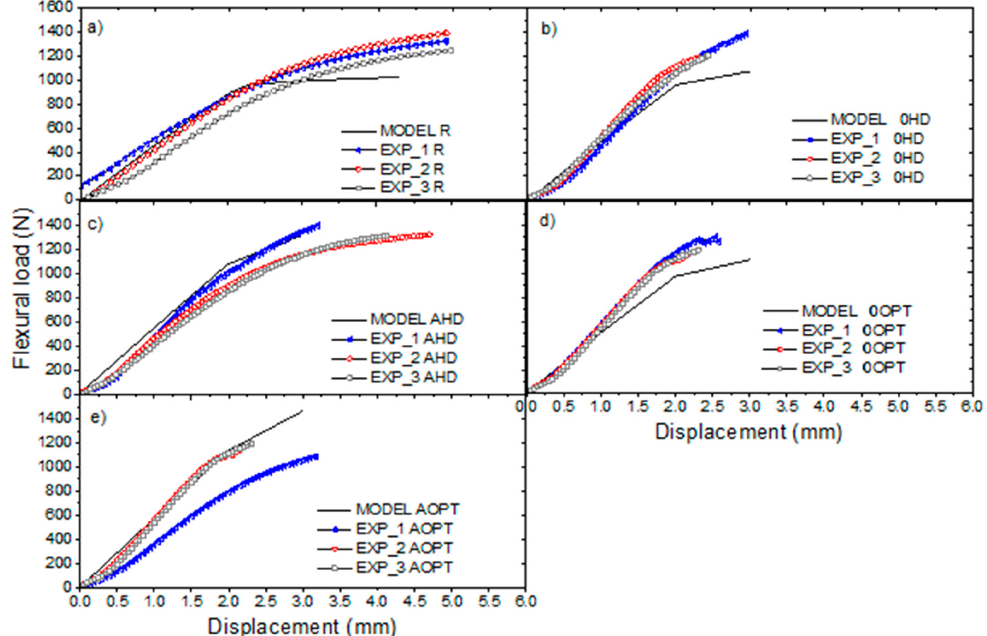
Figure 9. Numerical and experimental flexural load vs. displacement curves for ( a ) R, ( b ) 0HD, ( c ) AHD, ( d ) 0OPT and ( e ) AOPT designs. The EXP_X curves are referenced as the experimental curve for each sample (three for each SP configuration).